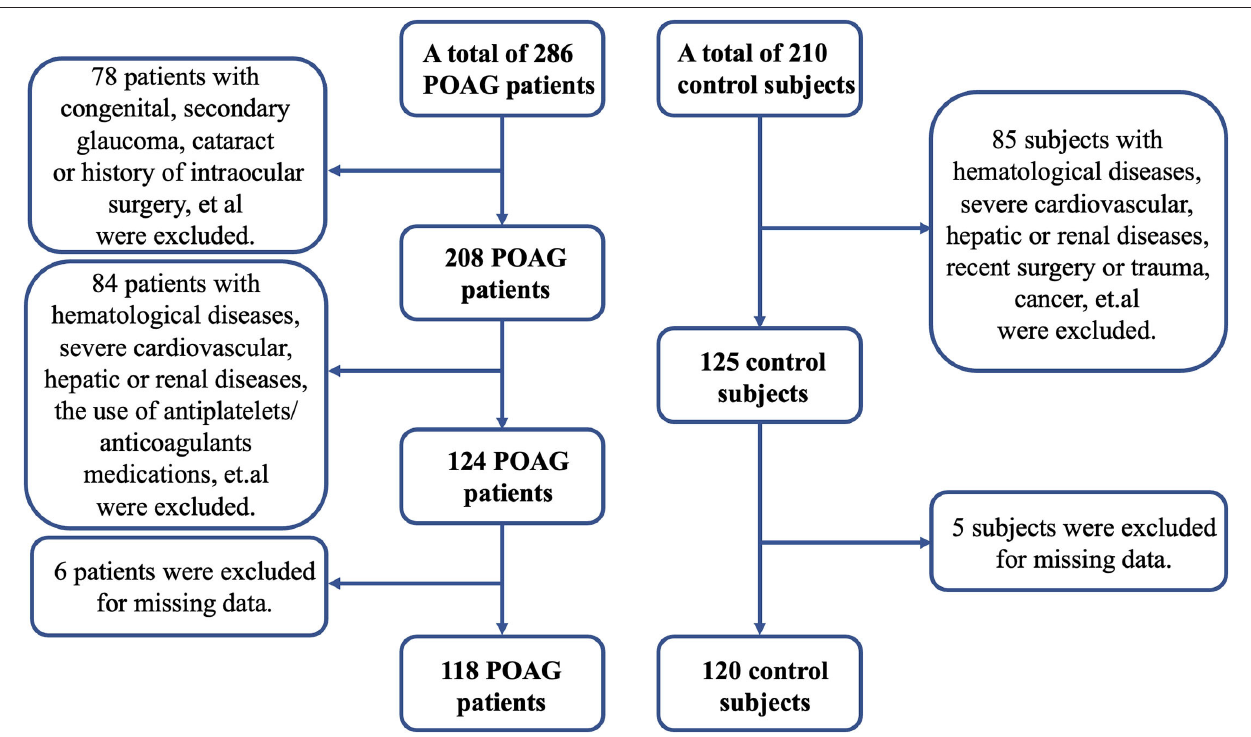
FIGURE 1 | The flowchart of the study regarding subject